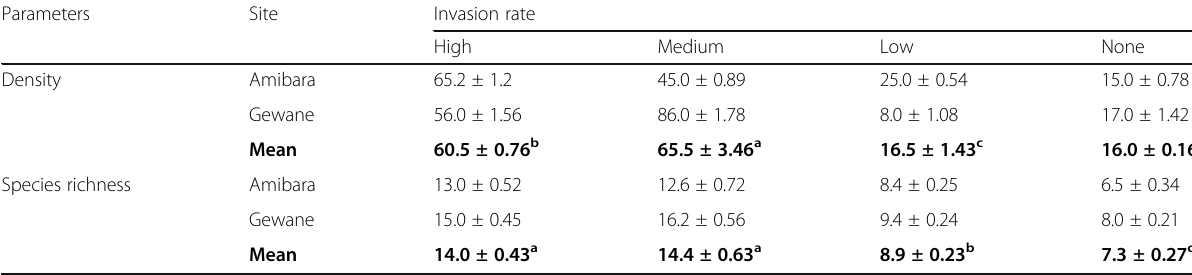
Table 3 Number and abundance of species in soil seed bank by invasion rate Parameters